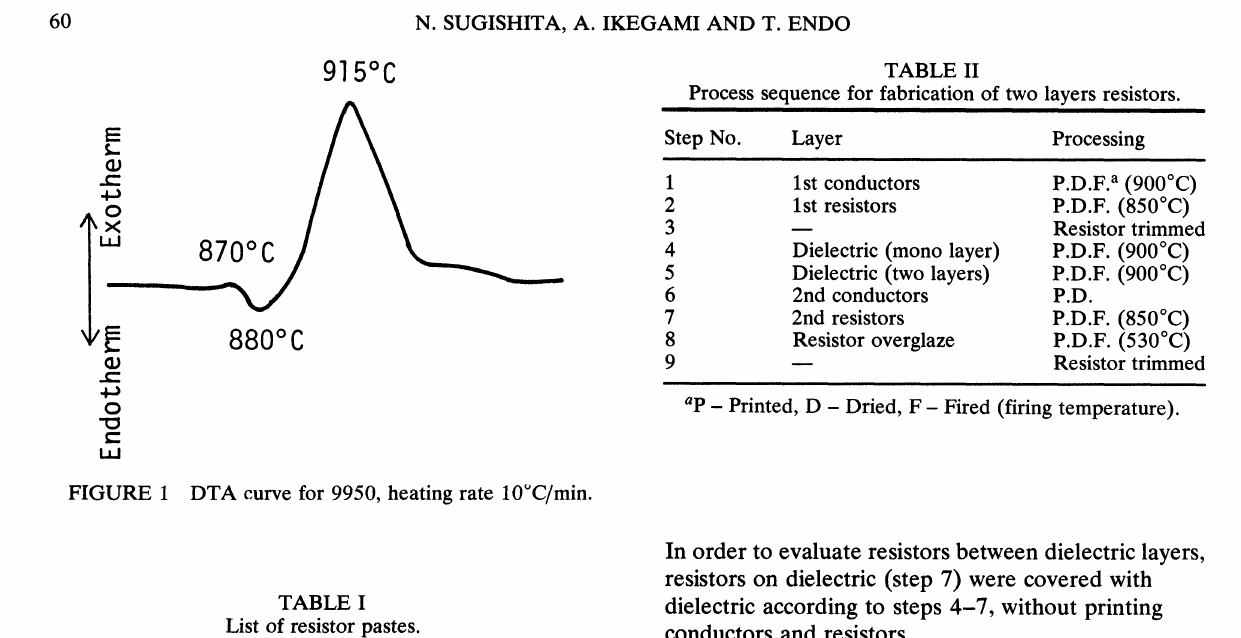
FIGURE DTA curve for 9950, heating rate 10C/min.